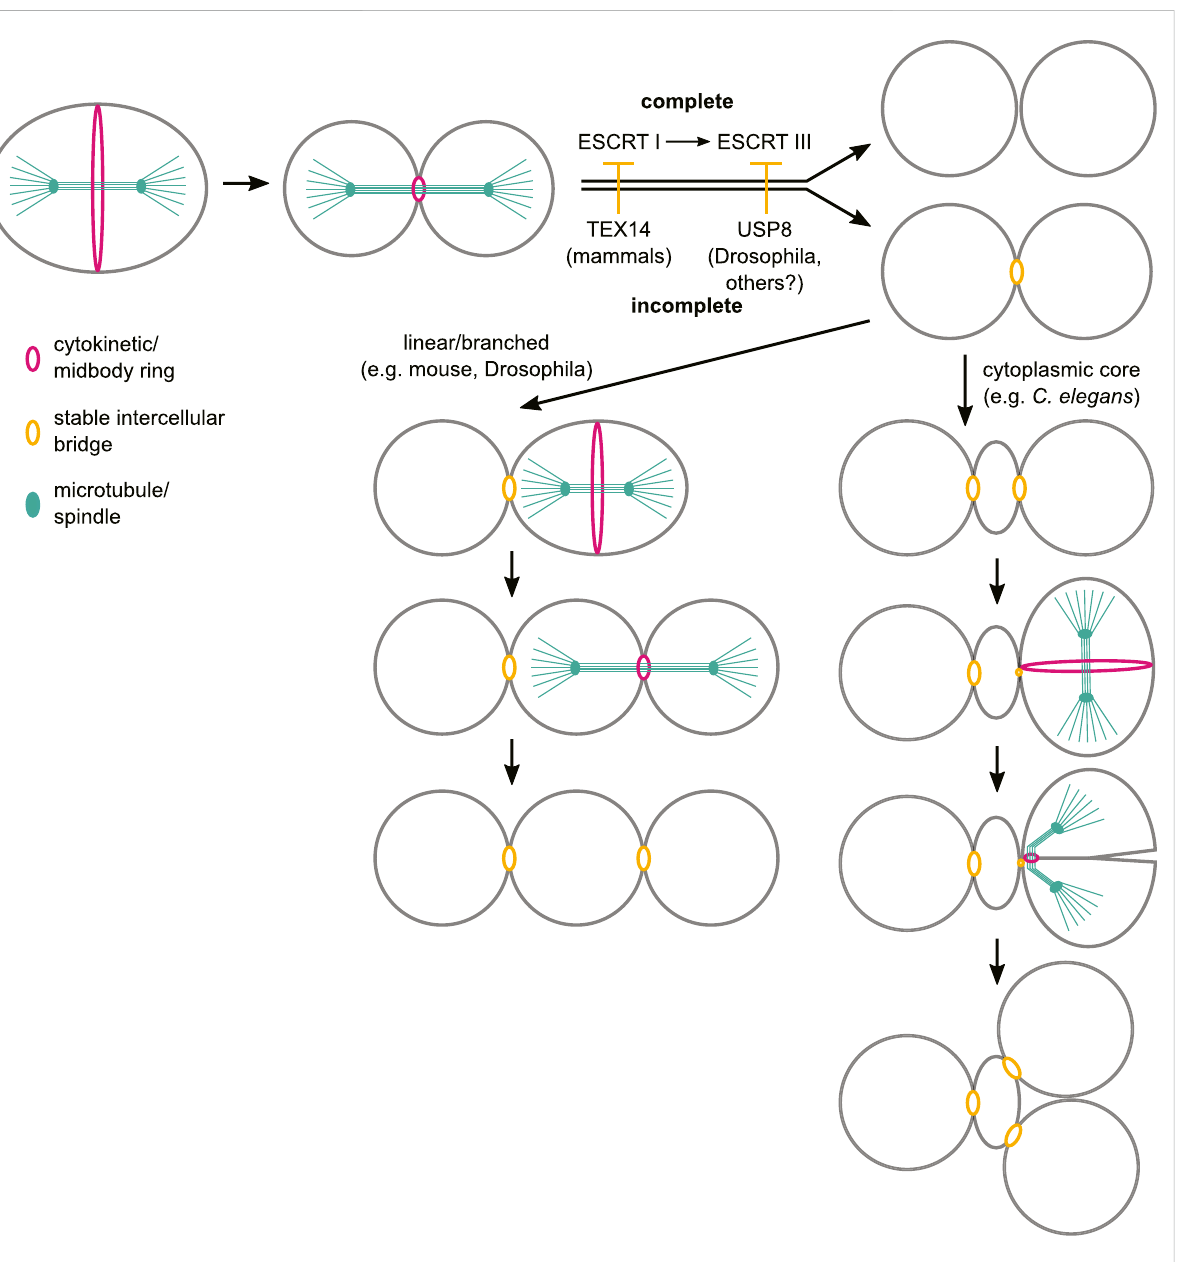
FIGURE 5 Stable intercellular bridge formation in germ cells by incomplete cytokinesis. In metazoans, stable intercellular bridges (orange) arise from the cytokinetic/midbody ring (magenta) following incomplete germ cell cytokinesis, through mechanisms that impede the activity of ESCRT componentsduringabscission.Theseeventsarereiteratedingermcellsthatdevelopwithinlinearandbranchedcysts(e.g.,mouse, Drosophila ),thus enabling cyst expansion. In architectures where germ cells are connected to an anucleate cytoplasmic core (e.g., C. elegans ), the stable intercellular bridges must undergo duplication through a mechanism that is currently unknown. We propose that subsequent germ cell divisions within thisarchitecture also occur byincompletecytokinesis,in amanner that allows one daughtercell to inherit thepre-existingstable intercellular bridge while the other daughter inherits the bridge arising of the cytokinetic/midbody ring. This mechanism requires further experimental validation and could also rely on bisection of the stable intercellular bridge by the cytokinetic ring, as was proposed previously ( Ś wi ą tek et al.,